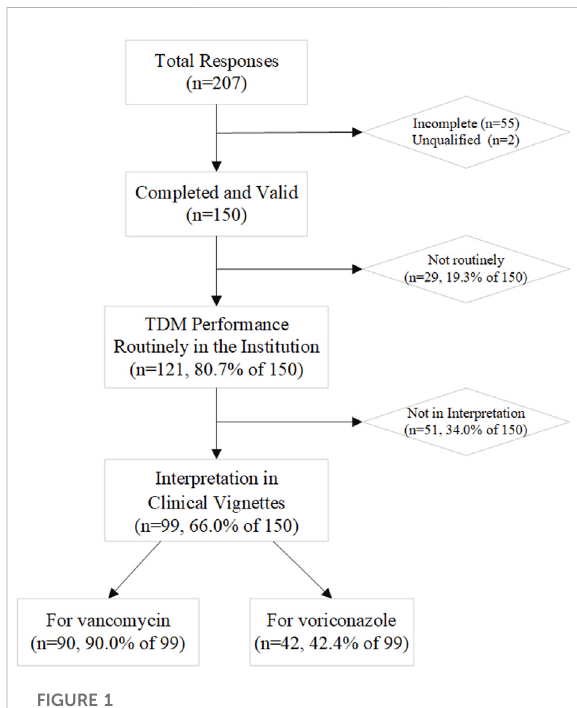
FIGURE 1 The fl ow chart shows the feedback of different sections.